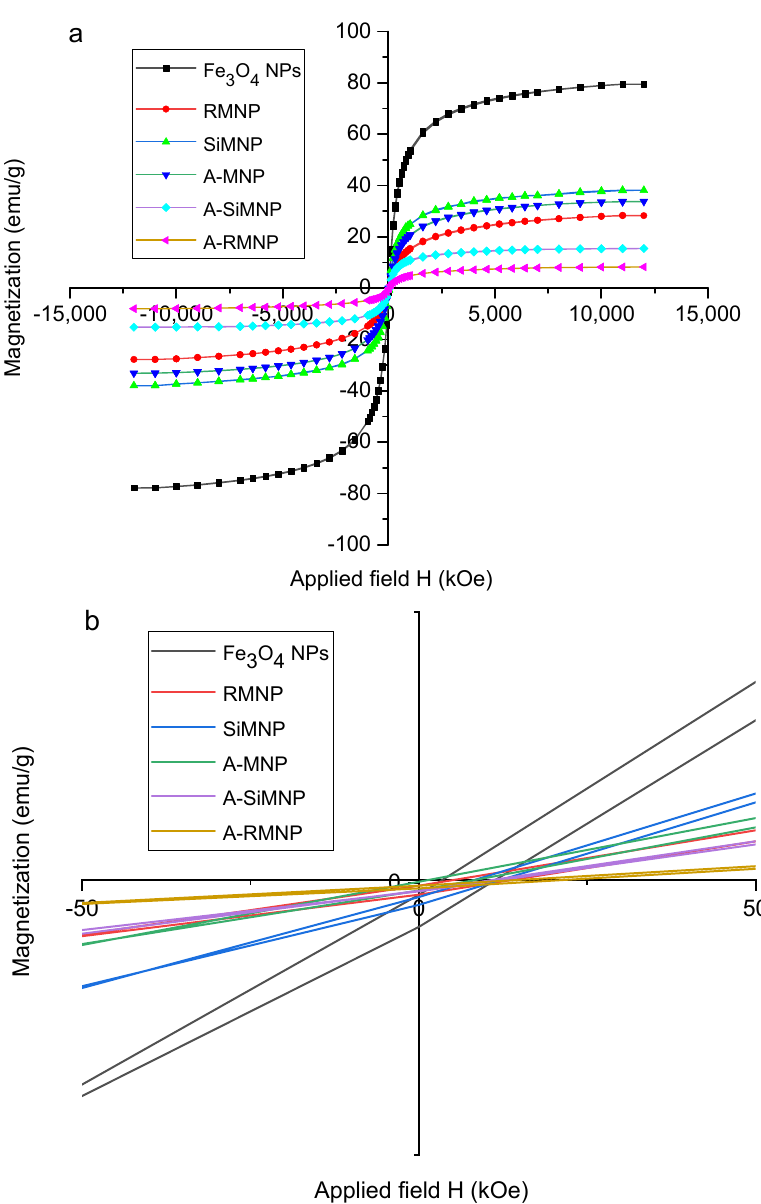
Figure 4. ( a ) Hysteresis loops for A-SiMNP, A-RMNP, A-MNP, RMNP, MNP, and SiMNP, ( b ) the magnification of the graph ( a ).